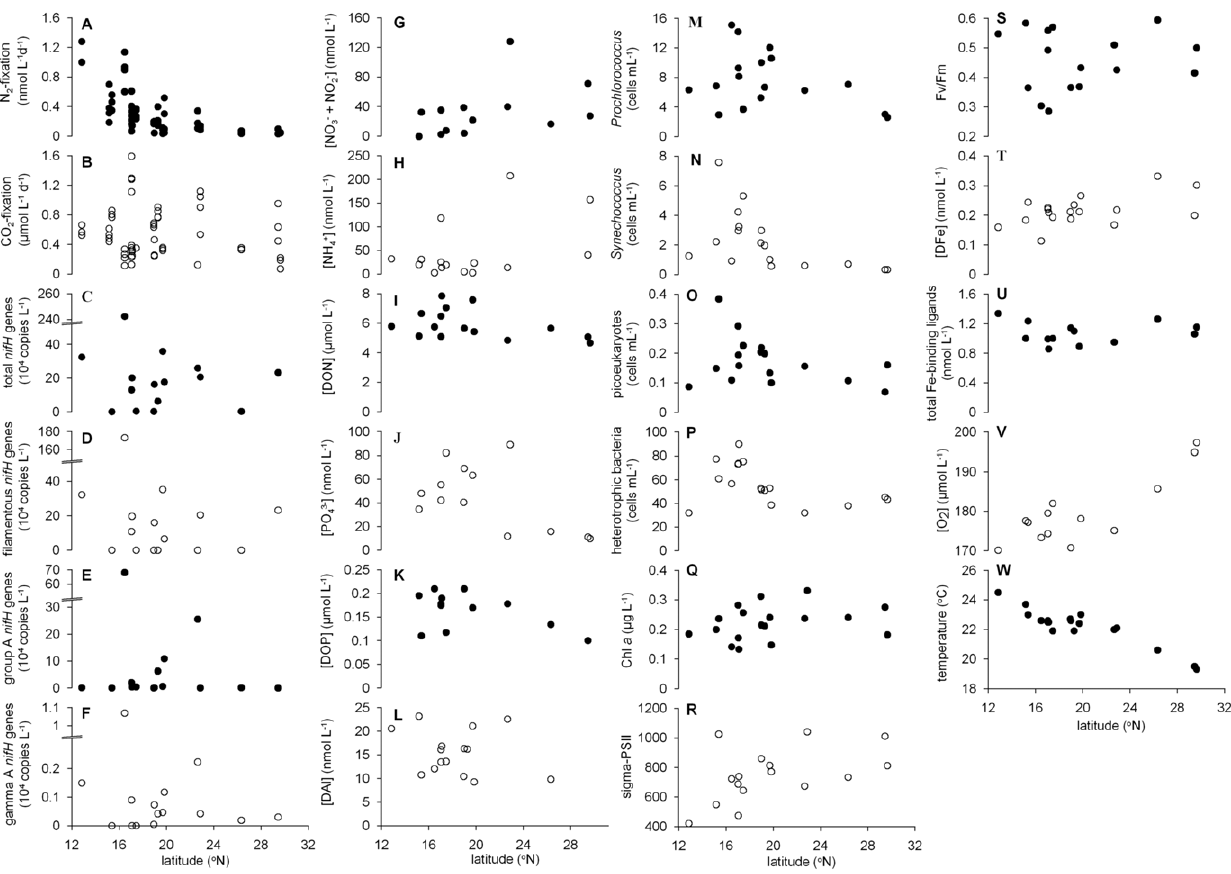
Figure 4. The environmental parameters measured during the P332 cruise in the Cape Verde region. The (A) N 2 fixation rate, (B) CO 2 fixation rate, (C) total nifH gene abundance, (D) filamentous nifH gene abundance, (E) group A nifH gene abundance, (F) gamma A nifH gene abundance, (G) NO 3- + NO 2- , (H) NH 4 + , (I) DON, (J) PO 43- , (K) DOP, (L) DAl, (M) Prochlorococcus spp. abundance, (N) Synechococcus spp. abundance, (O) picoeukaryote abundance, (P) heterotrophic prokaryote abundance, (Q) Chl a , (R) s PSII , (S) F v /F m , (T) DFe, (U) total Fe-binding ligands, (V) O 2 , (W) temperature as a function of latitude.